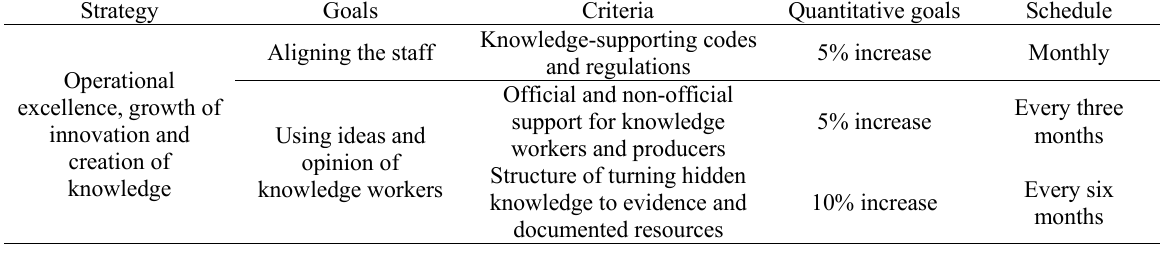
BSC for the internal processes dimension in knowledge management evaluation in petrochemical industries